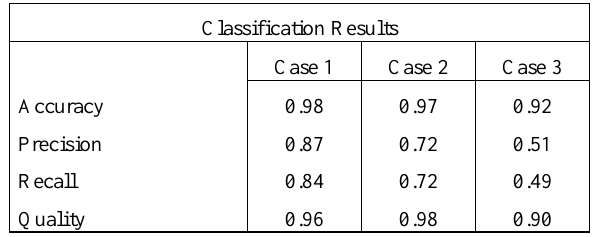
Table 4. Summary table of accuracy, precision, recall and quality.